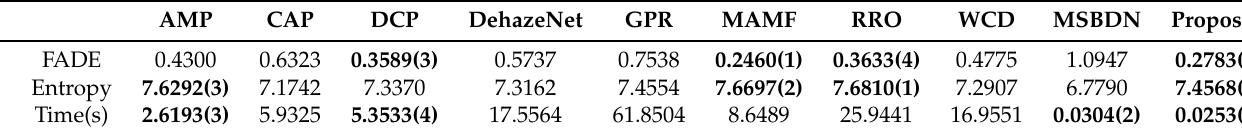
Table 1. Analysis of the defogging performance of the real-world foggy remote sensing images using three evaluation indicators. The top four results are marked in bold, and the corresponding rankings are shown in parentheses. The lower FADE value is better, the higher Entropy value is better.